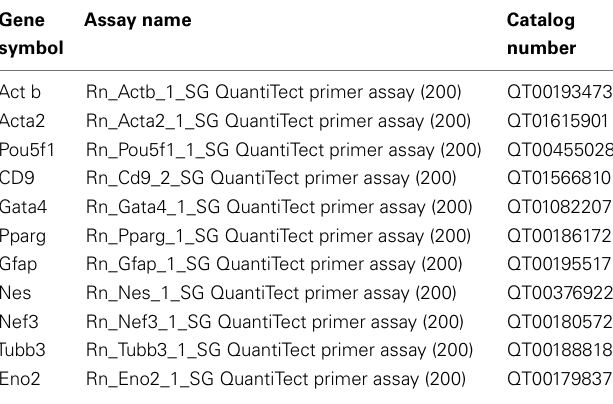
Table 1 | List of used QuantiTect primer